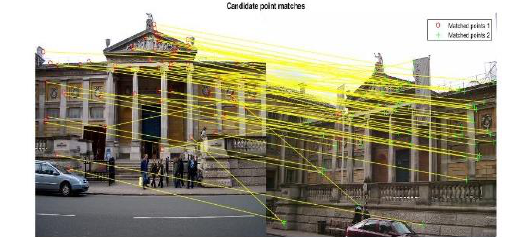
Figure 6. Executing the algorithm, using thresholds of 5 pixels for distance and 1  angle (All Souls College Oxford). Analyzing the result of applying the algorithm to many image pairs shows that the number of the inliers greatly depends on the selected distance and angle thresholds. If a high threshold is applied, the number of outliers could include inliers. Obviously, the threshold values depend on whether the two images are close to each other in terms of disparity. The case with significant rotation or translation between images as well as larger thresholds is shown in Figure 7. It can be seen from Figure 8, that the number of outliers increases significantly with increasing the threshold values.